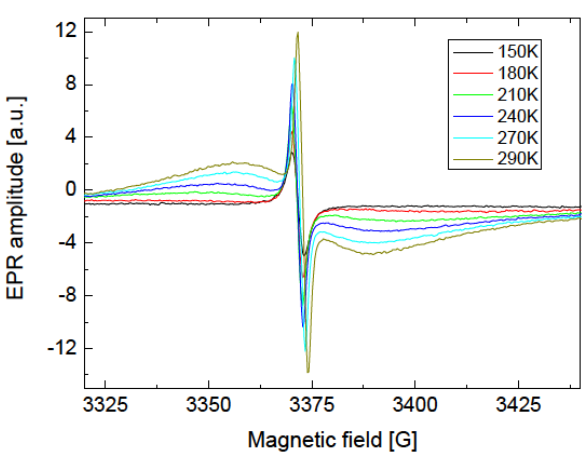
Figure 13: High temperature EPR spectra of B-800 sample showing the narrow N and broad BHT